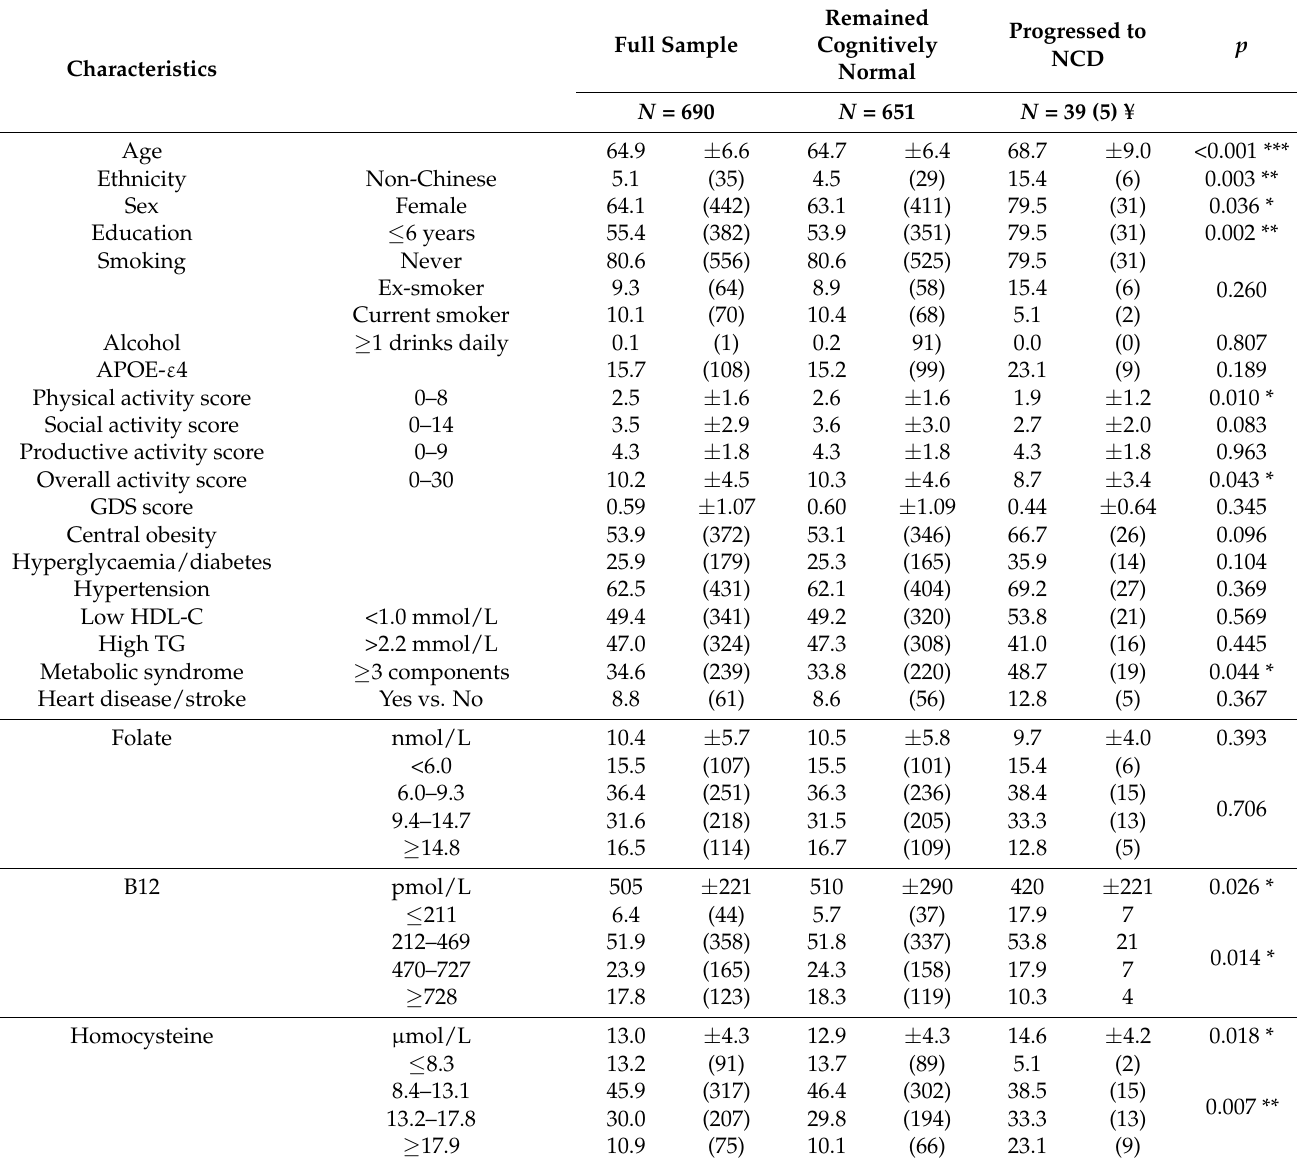
Table 1. Baseline characteristics of cognitively normal participants by cognitive outcomes at follow